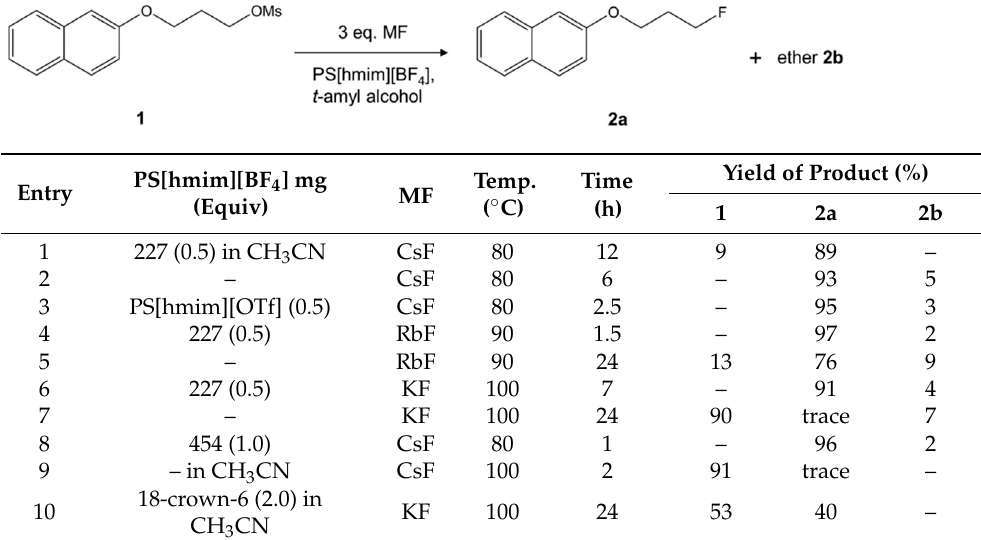
Table 5. Fluorinations of mesylate 1 with MF using PS[hmim][BF 4 ] in tert -amyl alcohol.